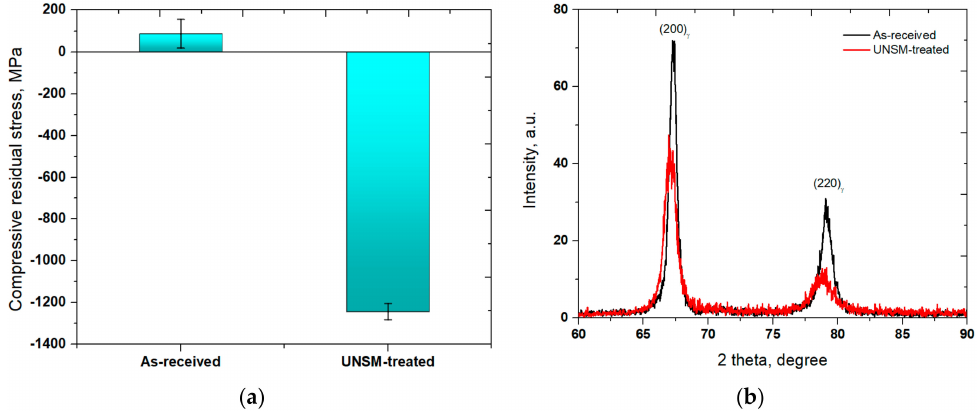
Figure 4. The surface residual stress measurement results ( a ) and XRD patterns ( b ) of the as-received and UNSM-treated